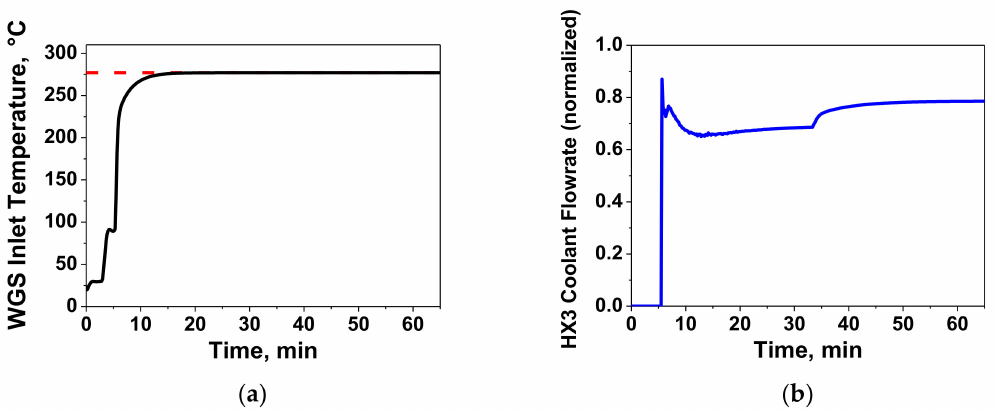
Figure 9. ( a ) Temperature profile of the WGS inlet (TC2 controller) and ( b ) coolant flowrate manipulation at the